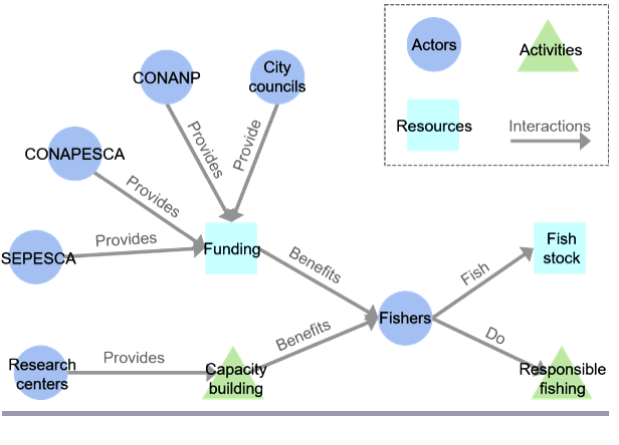
Fig. 3 . Group mental model of the representatives of the government agencies.